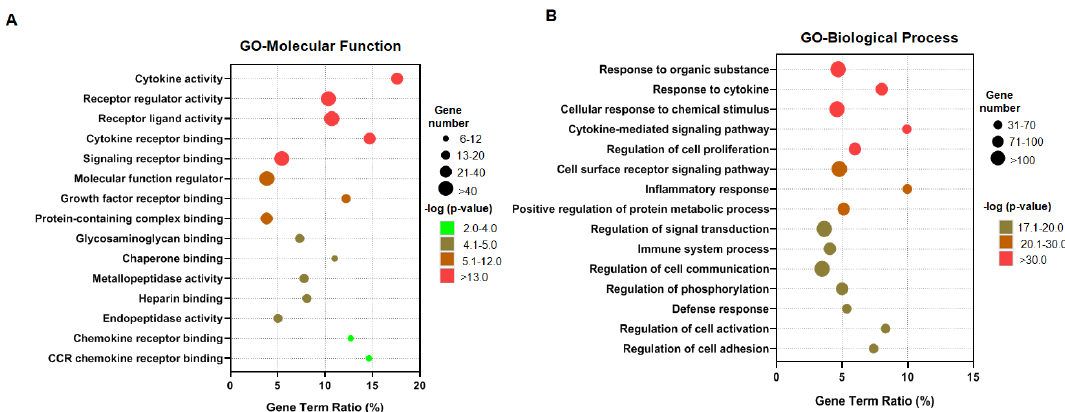
Figure 1. Functional annotation clustering by Gene Ontology (GO) and Kyoto Encyclopedia of Genes and Genomes (KEGG) pathway analysis identifies the enrichment of cytokine receptor signaling in Intervertebral disc (IVD) degeneration (IDD).GO analysis of IDD-related genes for ( A ) Molecular function and ( B ) Biological process. The top 15 enrichment pathways based on False Discovery Rate (FDR) p -value were shown in the bubble plot. The Y-axis label represents the pathway, and the X-axis label represents the gene term ratio (gene term ratio = gene numbers annotated in this pathway term / all gene numbers annotated in this pathway term). The size of the bubble represents the number of IDD-related genes enriched in the pathway, and color shows the corrected p value of the enriched pathway.